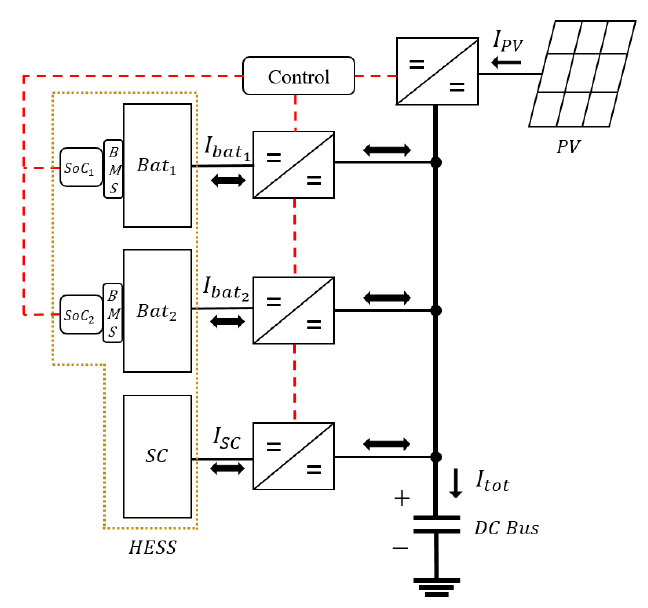
Figure 2. Complete system for DER integration in MG.